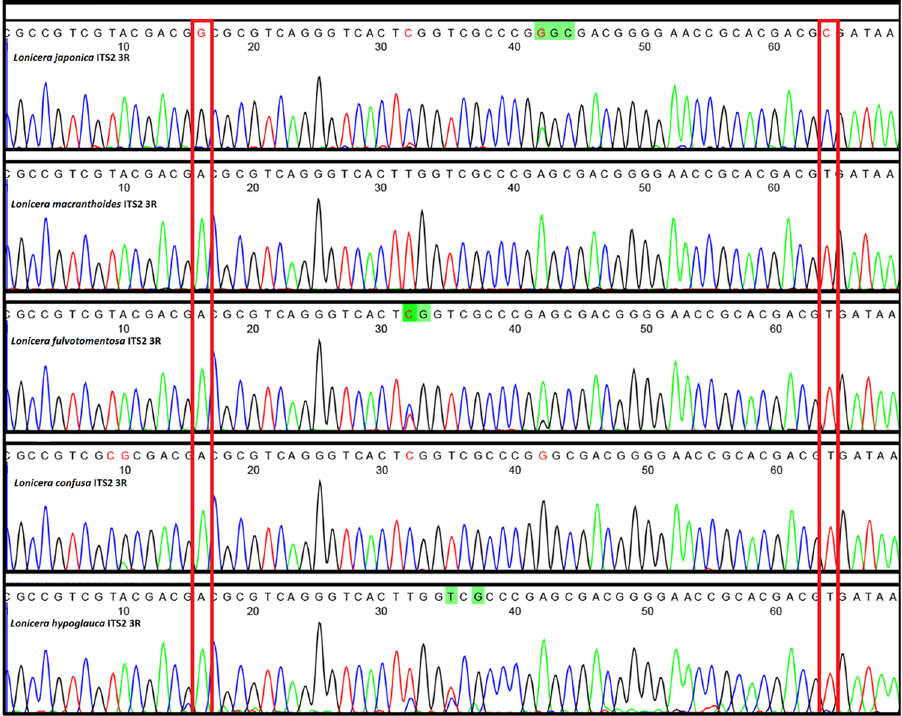
Figure 3. SNP peaks of Lonicera japonica and four originals of Lonicera Flos. Note: The Lonicera japonica and four species of Lonicera were amplified by ITS2F/3R, different bases were represented by different height of peaks and four different colours, two SNP sites were framed in this peak profile, respectively.